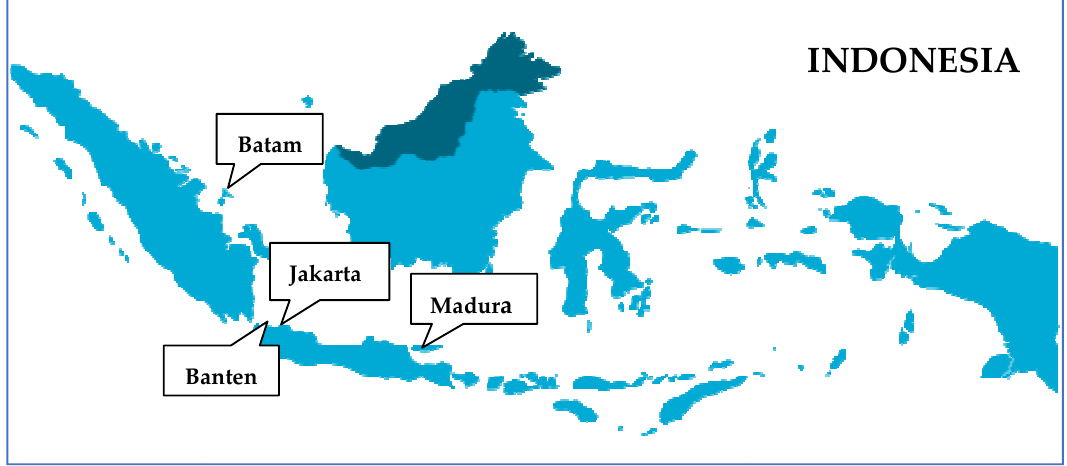
Figure 1. Locations of the ship-breaking yards visited.